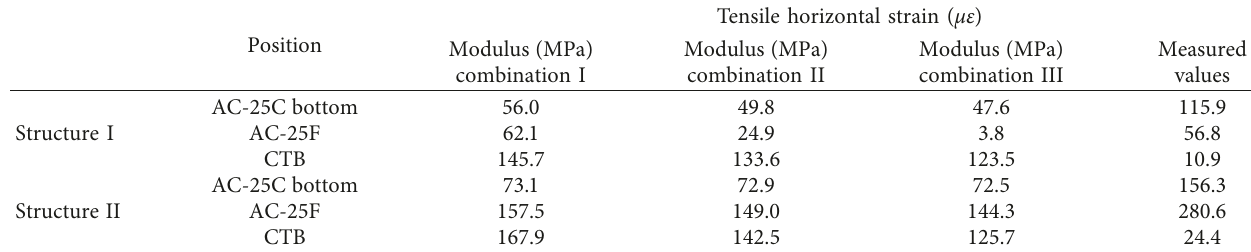
Table 5: Tensile horizontal strain.